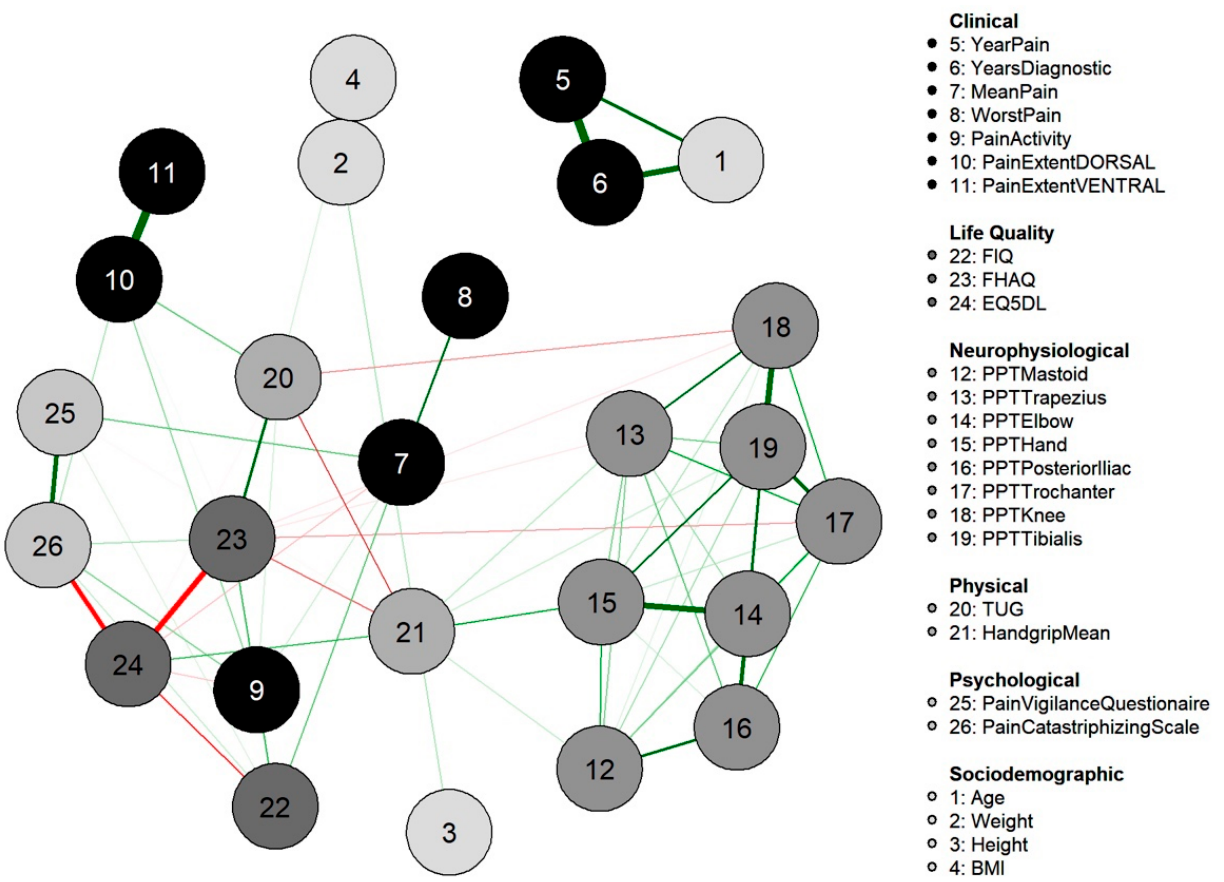
Figure 2. Network analysis of the association between demographic, clinical, cognitive, psycho- physical, health-related, and physical measures. Edges represent connections between two nodes and are interpreted as the existence of an association between two nodes, adjusted for all other nodes. Each edge in the network represents either positive regularized adjusted associations (green edges) or negative regularized adjusted associations (red edges). The thickness and color saturation of an edge denotes its weight (the strength of the association between two nodes). The variability associated with the weight of each edge is depicted graphically in Figure 3. The non-overlap of the 95% CI of the edge between PPTs at the lateral epicondyle and posterior iliac crest locations (nodes 14 and 16) with the 95% CI of the edge between pain during daily living activities and FHAQ (nodes 9 and 23) indicates that the strength of former is significantly greater than the